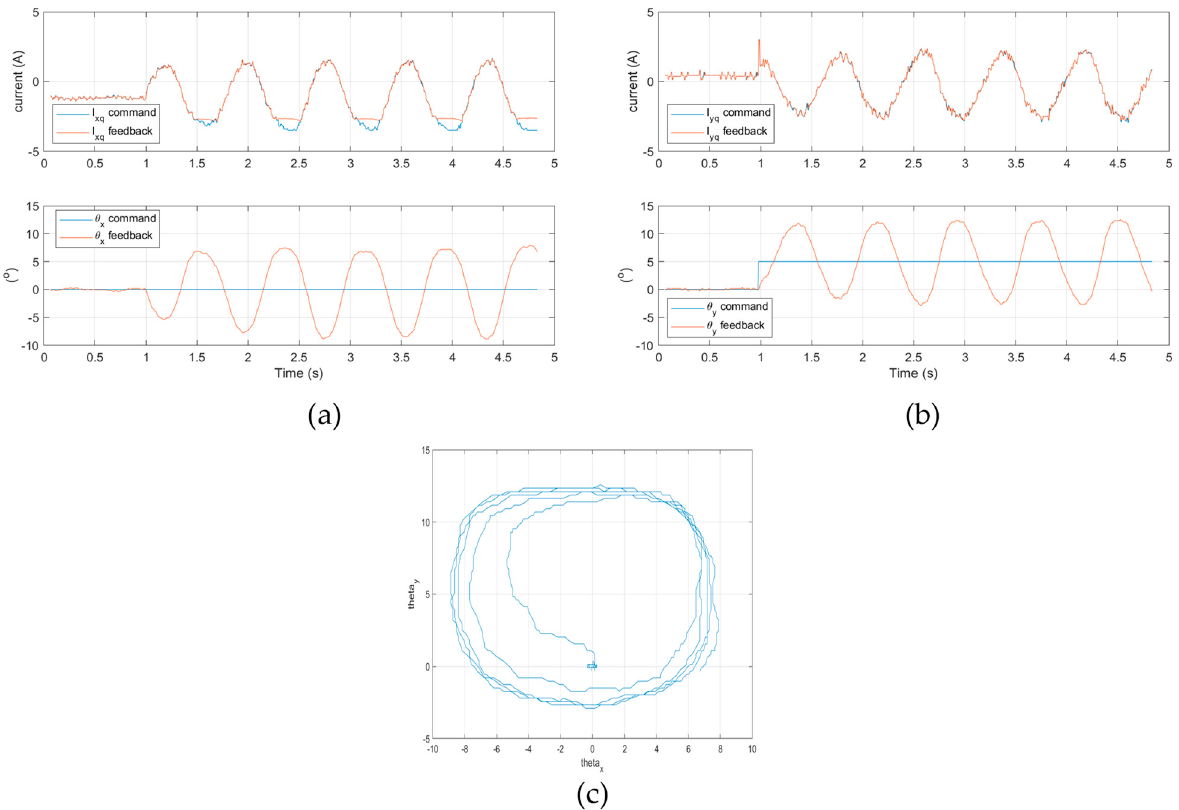
Figure 8. The experiment results for the position control of the HMDOF motor at the rotating motor speed of 1120 RPM (without feedforward compensator): ( a ) the control results of the roll motor; ( b ) the control results of the pitch motor; ( c ) the trajectory of the tilting motors on the θ x − θ y plane.